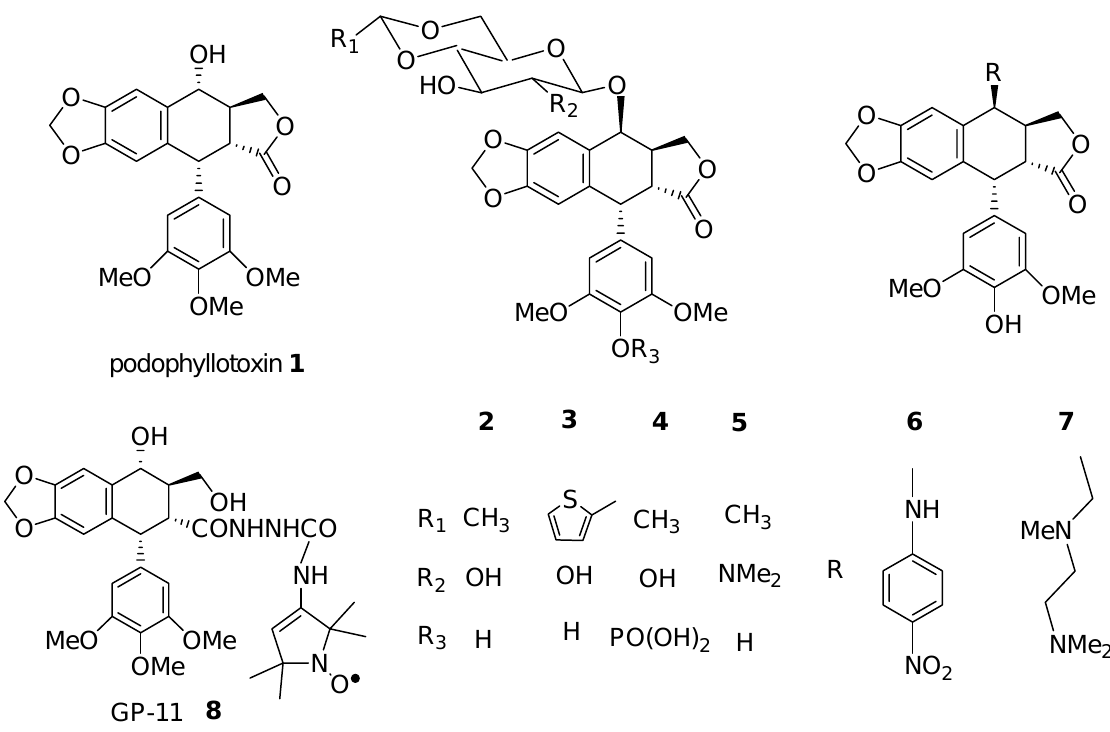
Figure 1. Podophyllotoxin and related